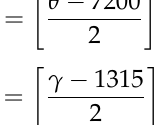
Table 5. The individual segment layer using 100000 samples with 50 runs.